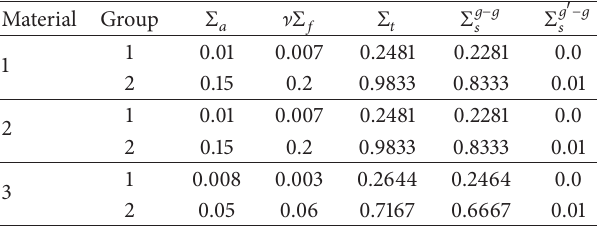
Table 1: Cross-section information in TWIGL problem ∗ .